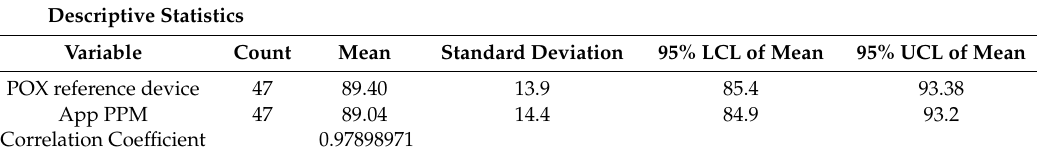
Table 2. Descriptive statistics between the two methods and their correlation coe ffi